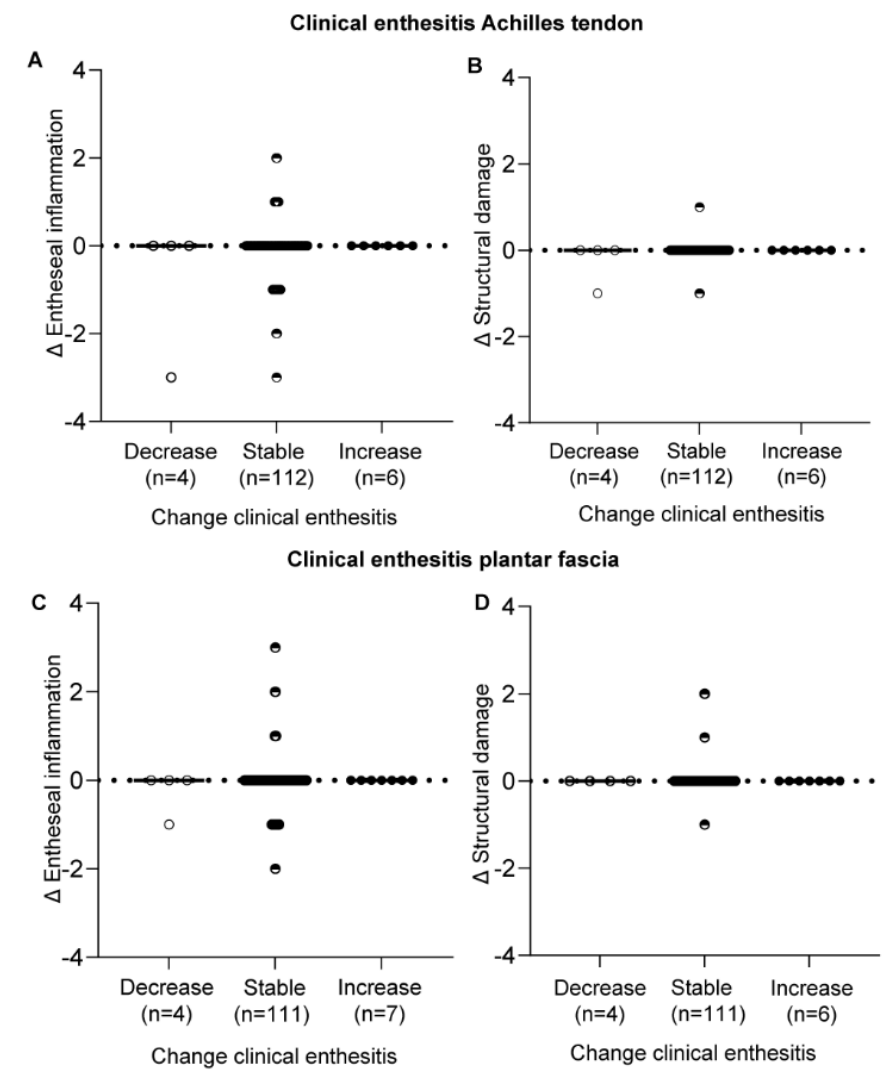
Figure 5. Change in the HEMRIS in patients with different levels of change in clinical enthesitis. Changes in clinical disease activity at the enthesis were not associated with changes in HEMRIS Entheseal inflammation at the Achilles tendon ( A , B ) and the plantar fascia ( C , D ). Data are presented as the median change and individual values of change in HEMRIS Entheseal inflammation and structural damage scores. Figure Legend: Abbreviations: ∆ = delta, HEMRIS = Heel Enthesitis Scoring System.